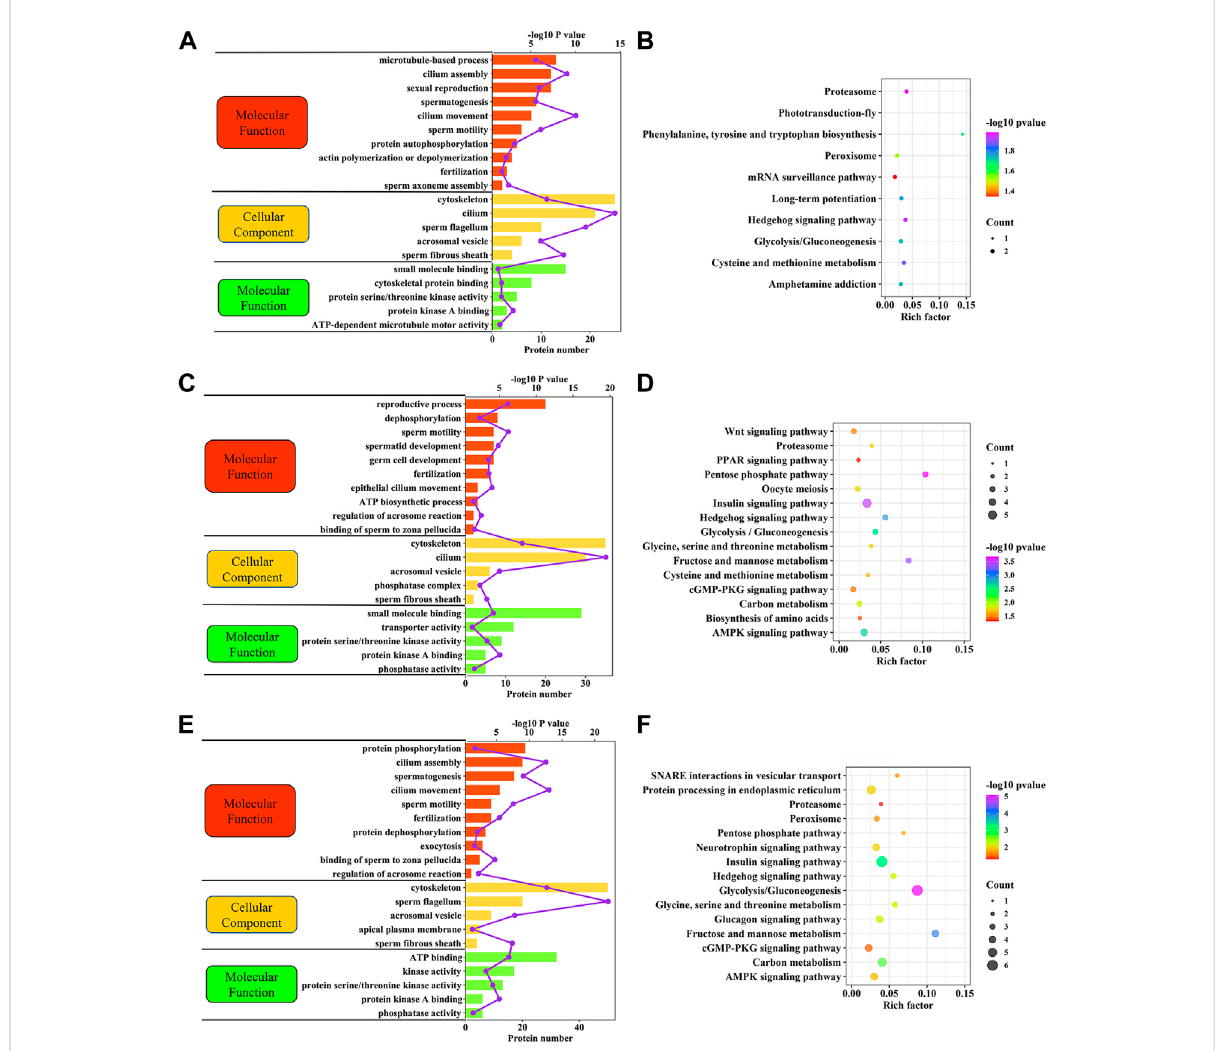
Functional enrichment analyses of DEPPs in yak sperm under capacitation and AR. (A) GO term enrichment analysis for CAP vs. FTH sperm comparison. (B) KEGG pathway enrichment analysis for CAP vs. FTH sperm comparison. (C) GO term enrichment analysis for AR vs. CAP